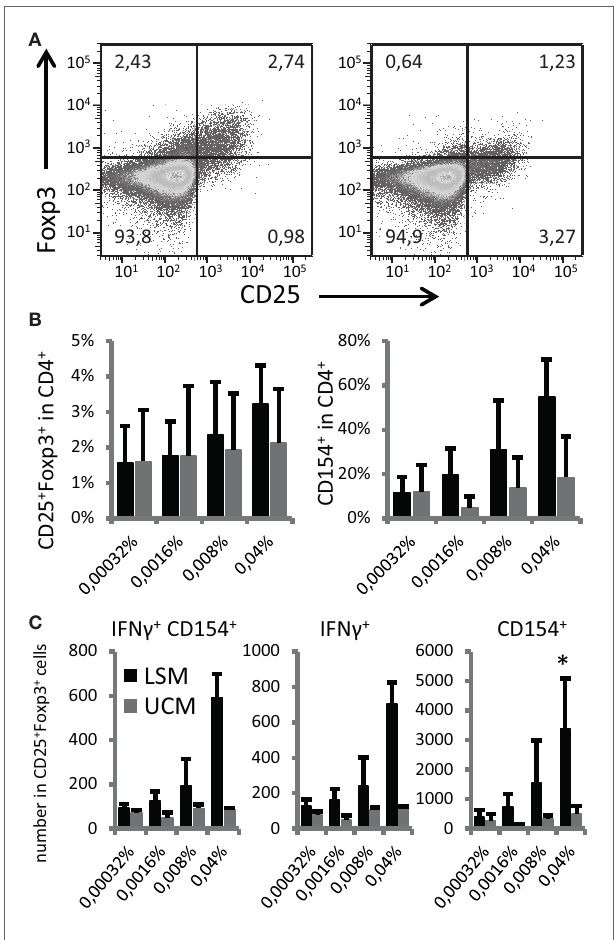
FigUre 3 | LGG soluble mediator (LSM)-modulated moDC induce enhanced Foxp3 + expression in activated T cells. (a) Representative plots of T cells co-cultured for 6 days with hemagglutinin (HA) and tetanus toxoid (TT) pulsed dendritic cells (DCs) that were differentiated from monocytes in the presence of LSM (left) or UCM (right). (B) Percentage of CD25 + Foxp3 + and CD154 + T cells after 6 days of co-culturing with HA and TT pulsed DCs that were differentiated from monocytes in the presence of LSM or UCM. (c) Total numbers of IFN- γ -positive and CD154-positive cells in the CD25 + Foxp3 + population in culture after stimulation. Data are average of at least three independent cultures ± SEM (* p <